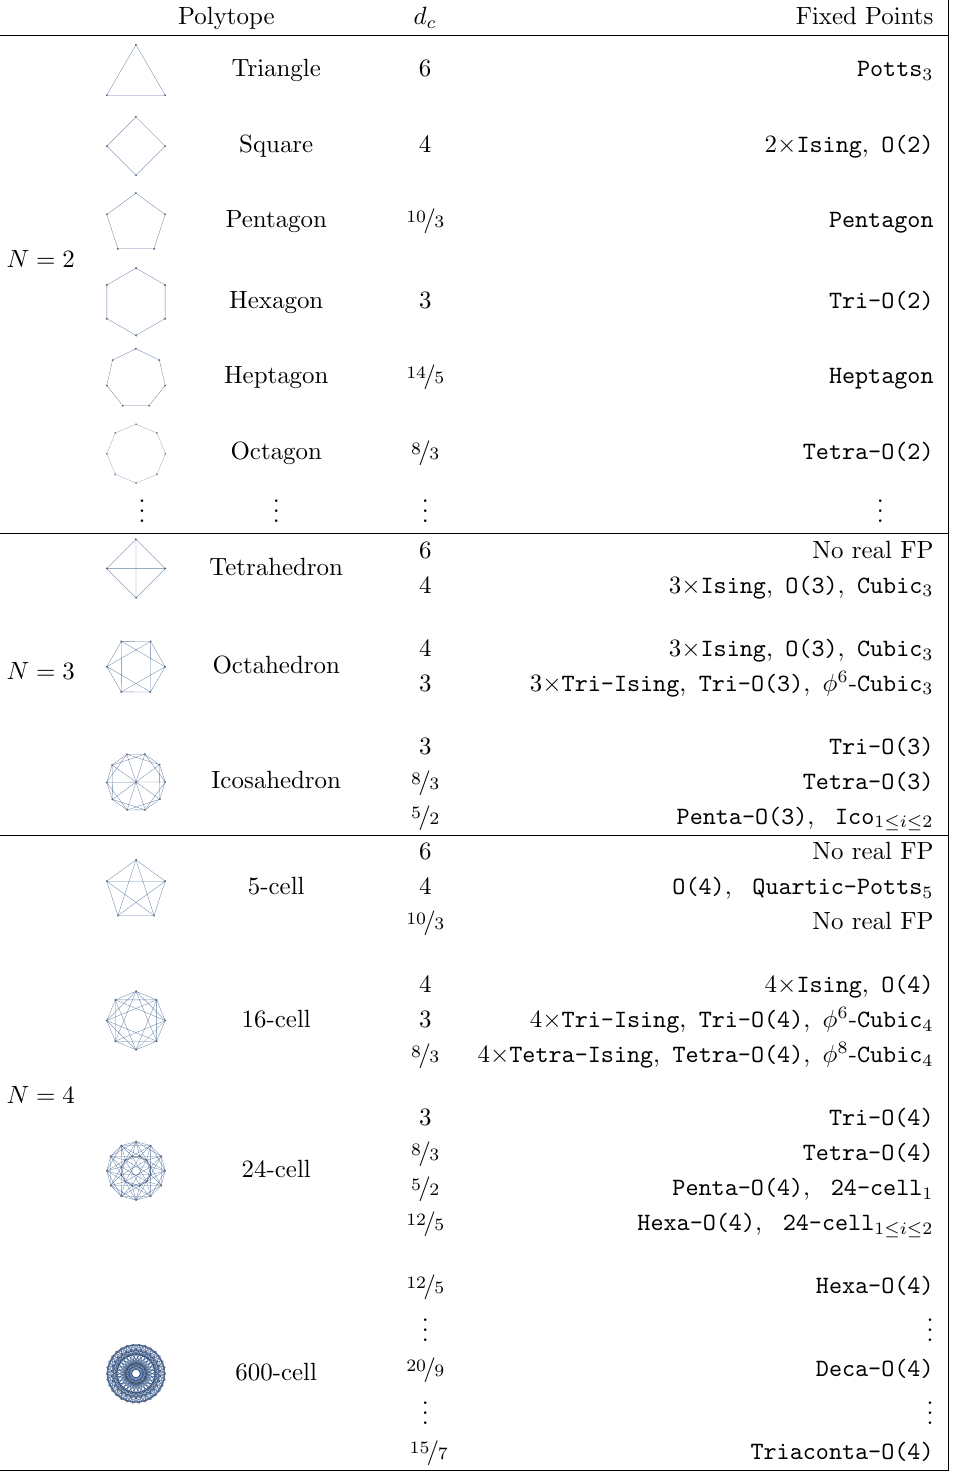
Table 3 . N -dimensional regular polytopes along with the upper critical dimensions d c around which the corresponding PFT can be studied in the (cid:15) -expansion. For each polytope and d c we report the real FPs found in our analysis.